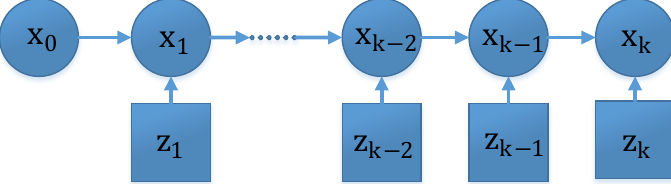
Figure 1. Recursive Bayesian estimation model. The first horizontal row represents the states of the system, which propagate in terms of Equation (31), and the column represents the measurement process, which is formulated by Equation (32). x 0 , x 1 , x k−2 , x k−1 , x k are the system states from time 0 to time k and z 1 , z k−2 , z k−1 ,z k are the measurements from time 1 to time k.